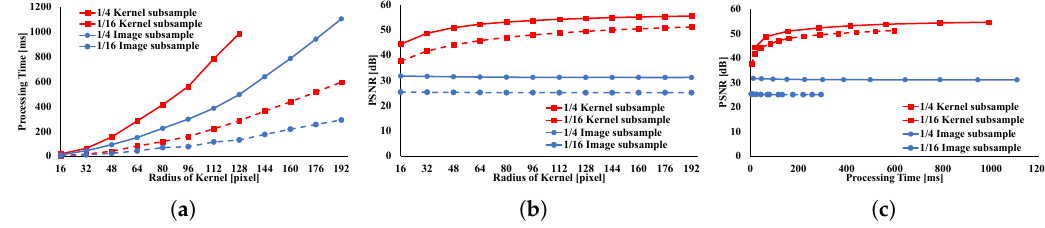
Figure A1. Processing time for and accuracy of image subsampling and kernel subsampling with respect to kernel radius of FIR filtering. ( a ) Processing time; ( b ) PSNR; ( c ) PSNR vs. processing time. Image size is 512 ×